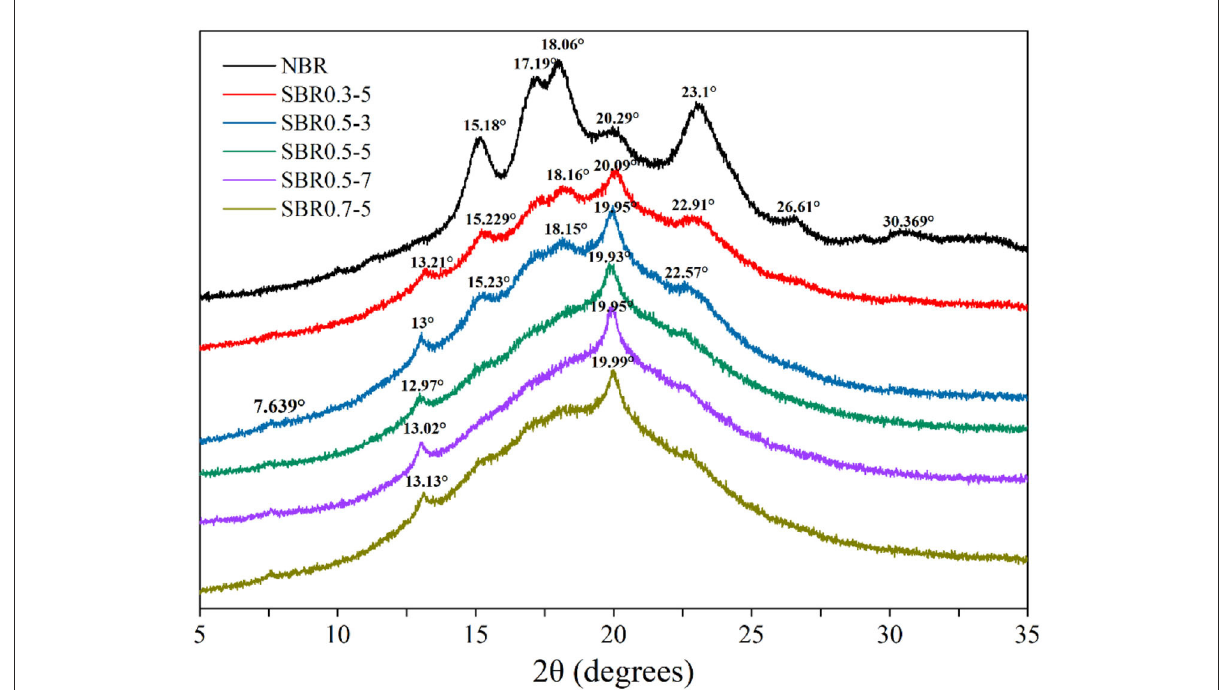
FIGURE2 XRD patterns of native and steam exploded brown rice powder. NBR, native brown rice powder; SBR, steam exploded brown rice powder; SBR0.3-5, SBR at 0.3 MPa for 5min; SBR0.5-3, SBR at 0.5 MPa for 3min; SBR0.5-5, SBR at 0.5 MPa for 5min; SBR0.5-7, SBR at 0.5 MPa for 7min; and SBR0.7-5, SBR at 0.7 MPa for 5min.